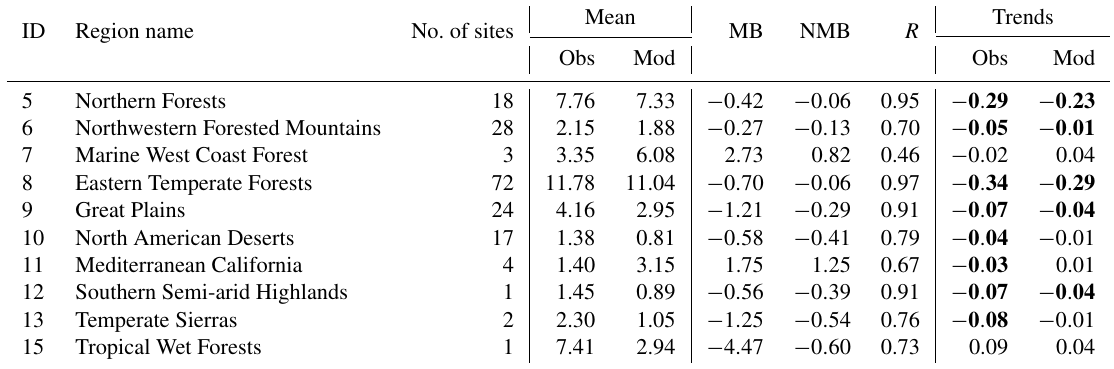
Figure 3. Comparison of the WDEP trend for each valid site between the precipitation-adjusted model values and observations for total oxidized nitrogen (TNO 3 , a ), reduced nitrogen (NH x , b ), and total sulfate (TS, c ). Each NADP site is assumed to be valid for our analysis only if at least 18 years of observation data are available at that site and the data coverage is at least 75% for each year. The green color is for the eastern US, and the red color is for the western US, with the dashed line for the 1:2 and 2:1 ratio and the solid line for the 1:1 ratio. Table 4. The same as Table 2 but for